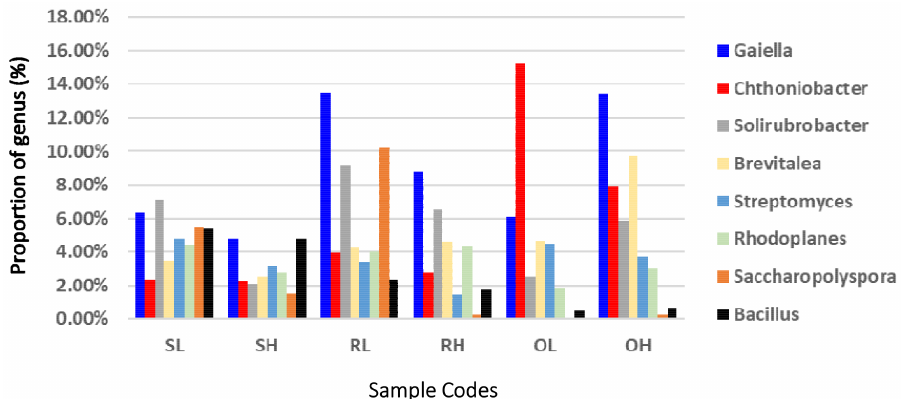
Figure 4. Relative abundance of the most frequent bacterial genera (>2% across all samples) in the rhizosphere of Brachystegia boehmii. Sample codes follow Figure